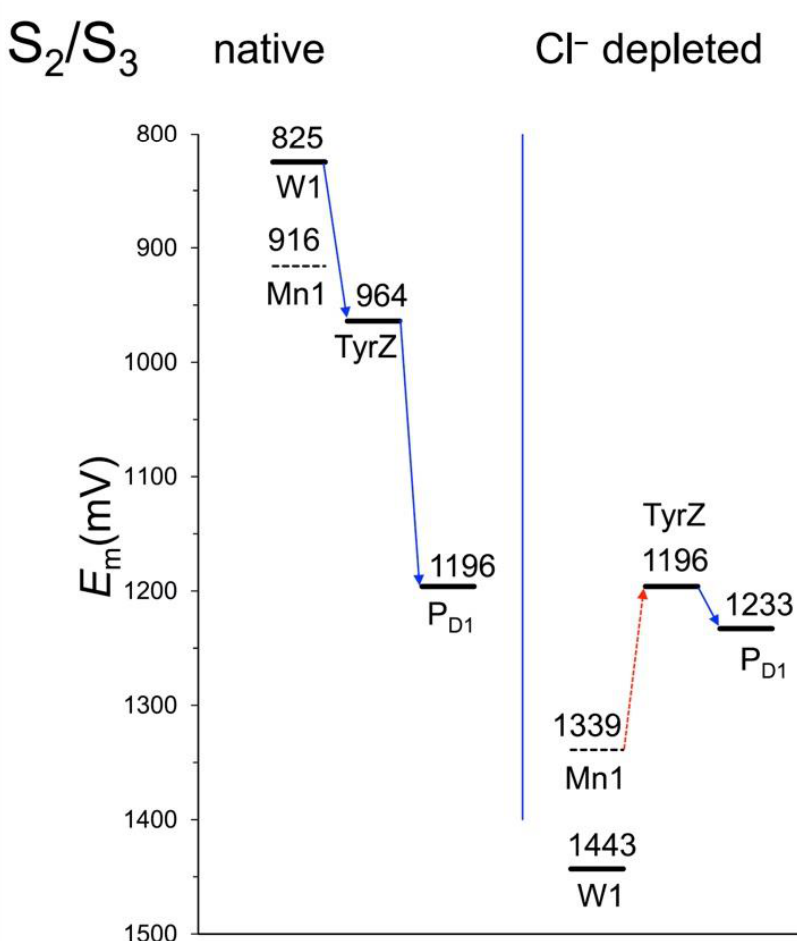
Figure 5. When a chloride ion (Cl – ) is present in the OEC, the transfer of an electron from water, via manganese ion 1 (Mn1) (and change between S 2 and S 3 states of the OEC) and tyrosine Z, to the plastoquinone B (Q B ) on the D1 polypeptide goes downhill, i.e., toward higher redox potential (E m ). In the absence of Cl – , the redox potential of Mn1 is increased beyond that of tyrosine Z, and Mn1 cannot be oxidized; the electron transfer to tyrosine Z is blocked. From Mandal et al. [16]. Reproduced with permission from the authors. A detailed energy diagram of the S 0 –S 1 –S 2 transitions in the native state was published by Siegbahn [19].